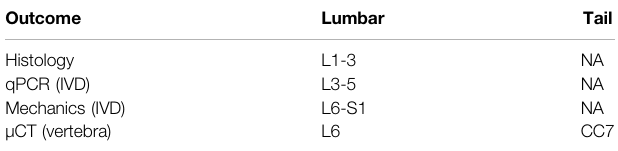
TABLE 2 | Outcomes for each spinal level. Outcome